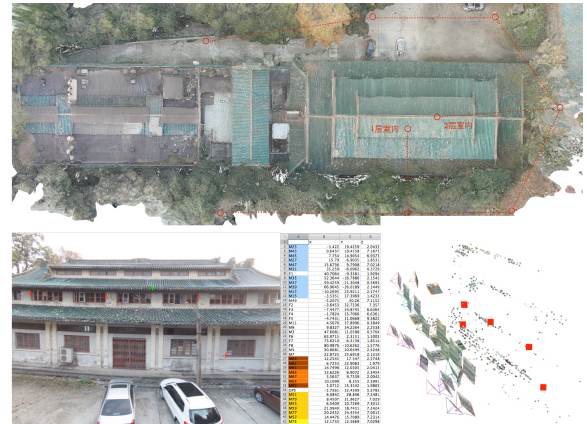
Figure 3. Setting up stations and integrating GCP with point clouds